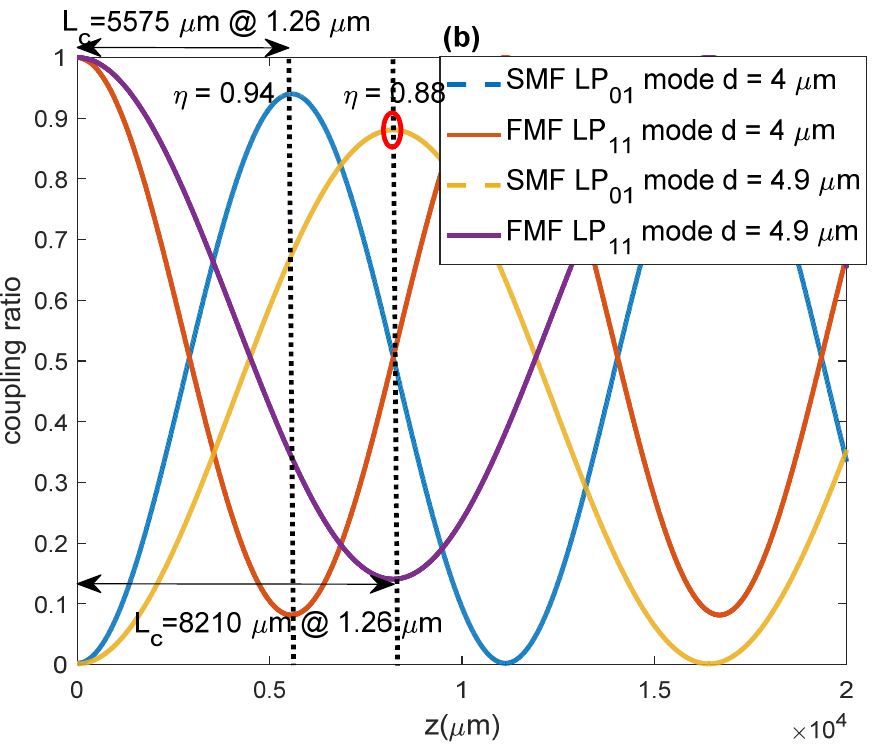
Figure 3. ( a ): Mode coupling varies with coupler length wavelength; ( b ) Mode coupling varies with core-to-core separation.